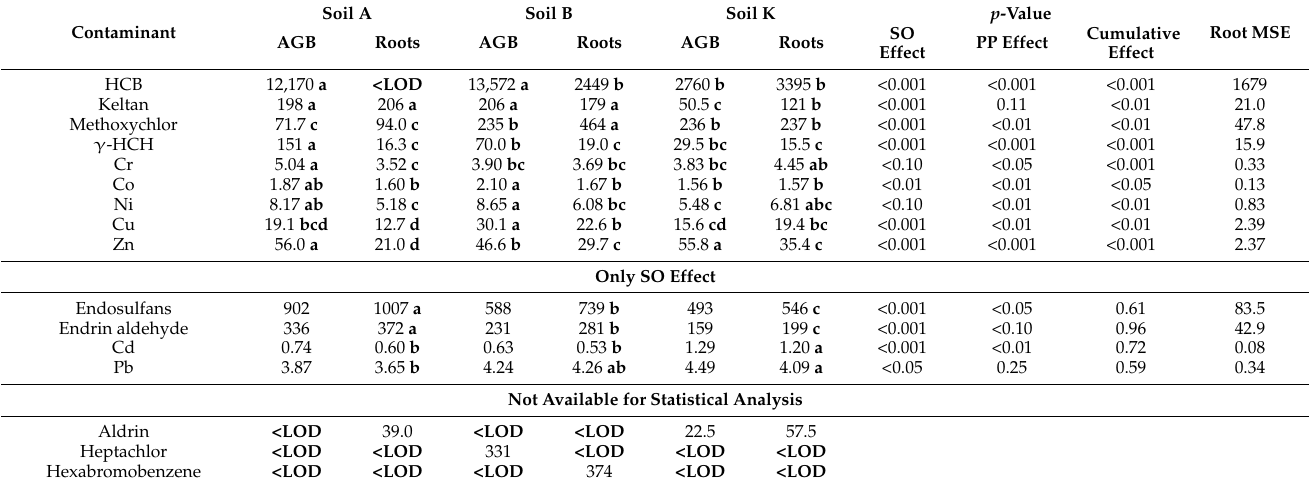
Table 3. OCPs and TTEs concentrations in AGB (sum of leaves and stems) and roots of P. tomentosa . Different letters within one compound indicate a significant